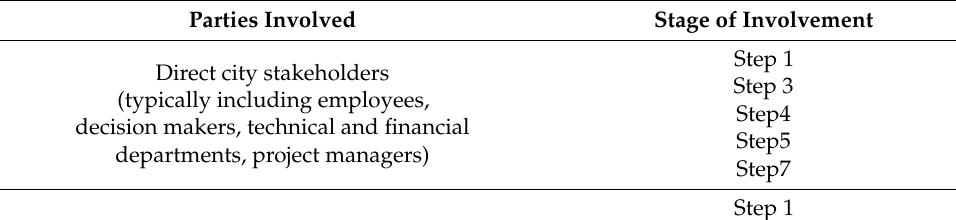
Table 2. List of study participants involved in the assessment methodology. Parties Involved Stage of